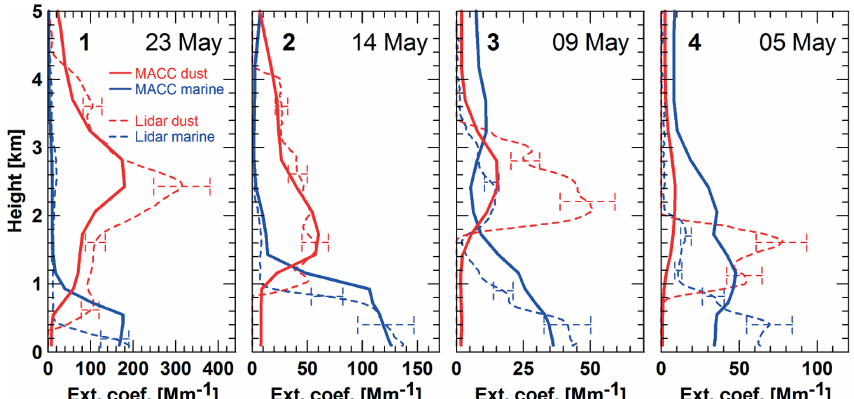
Figure 5. MACC/CAMS simulated marine (blue solid) and dust (red solid) contributions to particle extinction coefficient vs. respective lidar observations (dashed blue and red lines) for cases 1–4. Error bars show the overall retrieval uncertainty in the lidar observations. The variability in the modeled dust profiles around R/V Meteor are estimated to be 20–30% (case 1), 10–20% (case 2), 50–80% (case 3), and 20–30% (case 4; see text for more details).